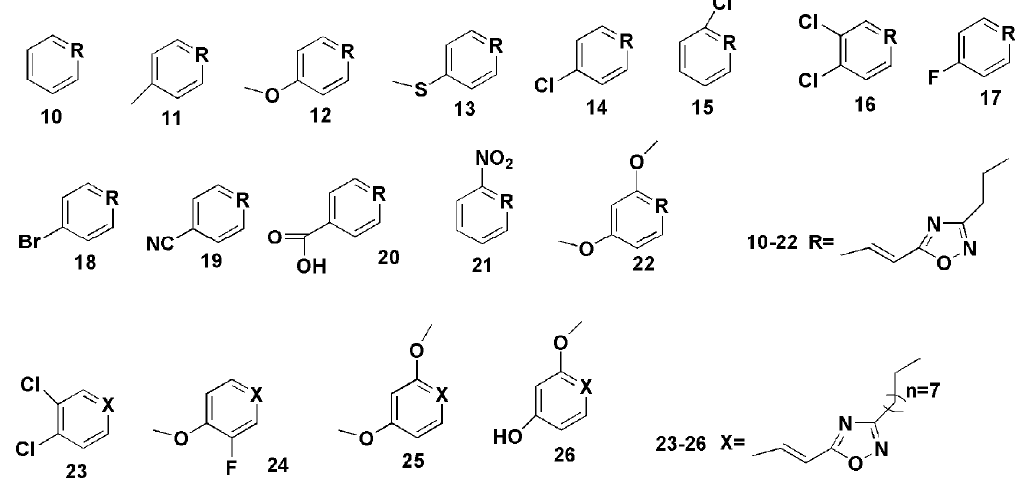
Figure 4. Chemical structures of the synthesized novel styryl oxadiazoles [24]. Table 2. In vitro anti-tubercular activity of compounds 10 – 26 against M.tb H37Ra on day 8 [24]. Compound IC 50 ( µ g /